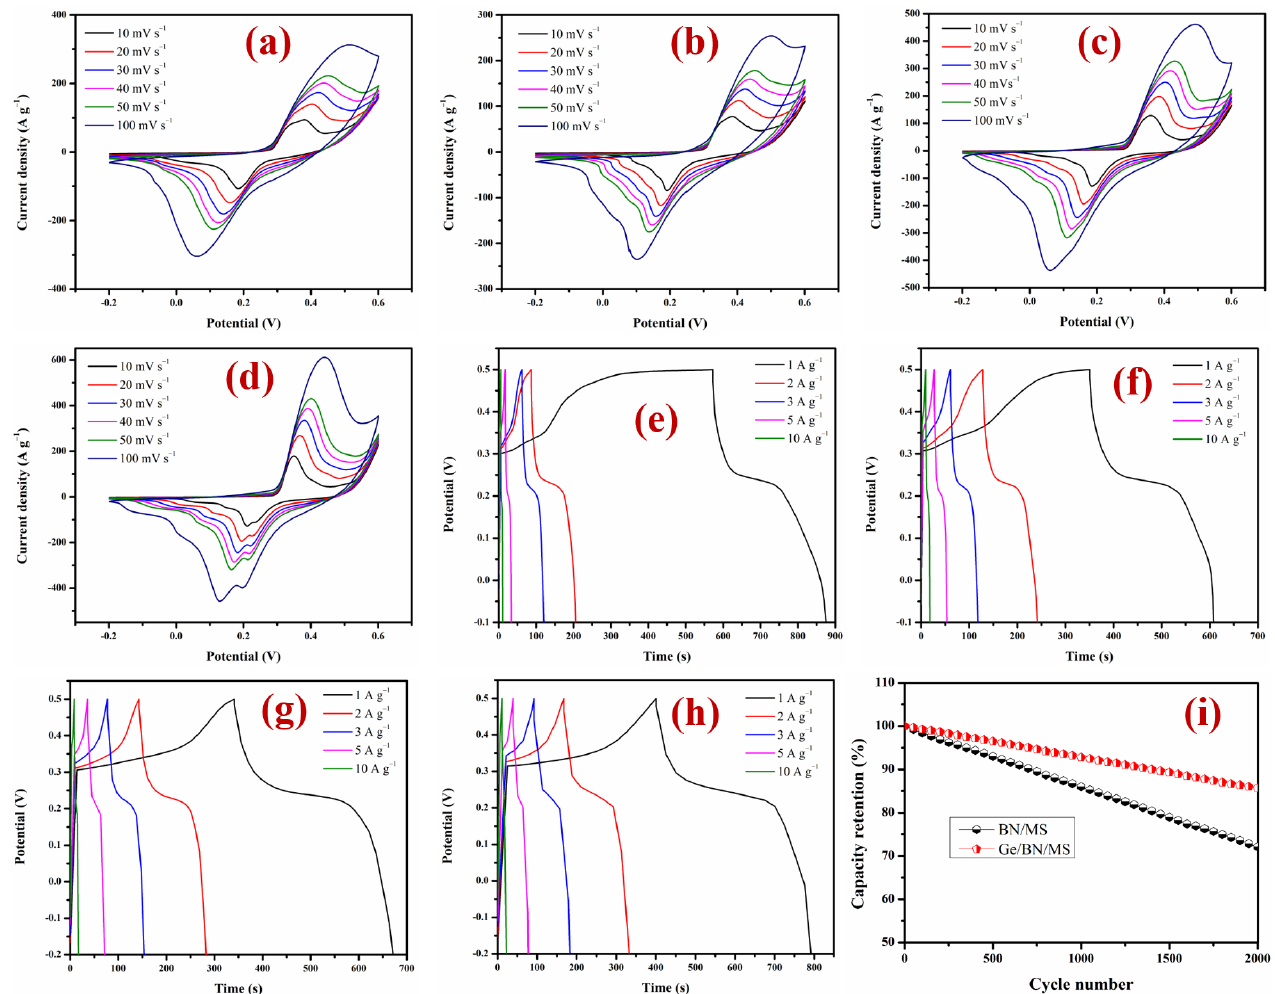
Figure 5. ( a , e ) CV and GCD of h-BN, ( b , f ) CV and GCD of MoS 2 , ( c , g ) CV and GCD of h-BN/MoS 2 , ( d , h ) CV and GCD of Ge/h-BN/MoS 2 , and ( i ) capacity retention of h-BN/MoS 2 and of Ge/h-BN/MoS 2 nanohybrid.